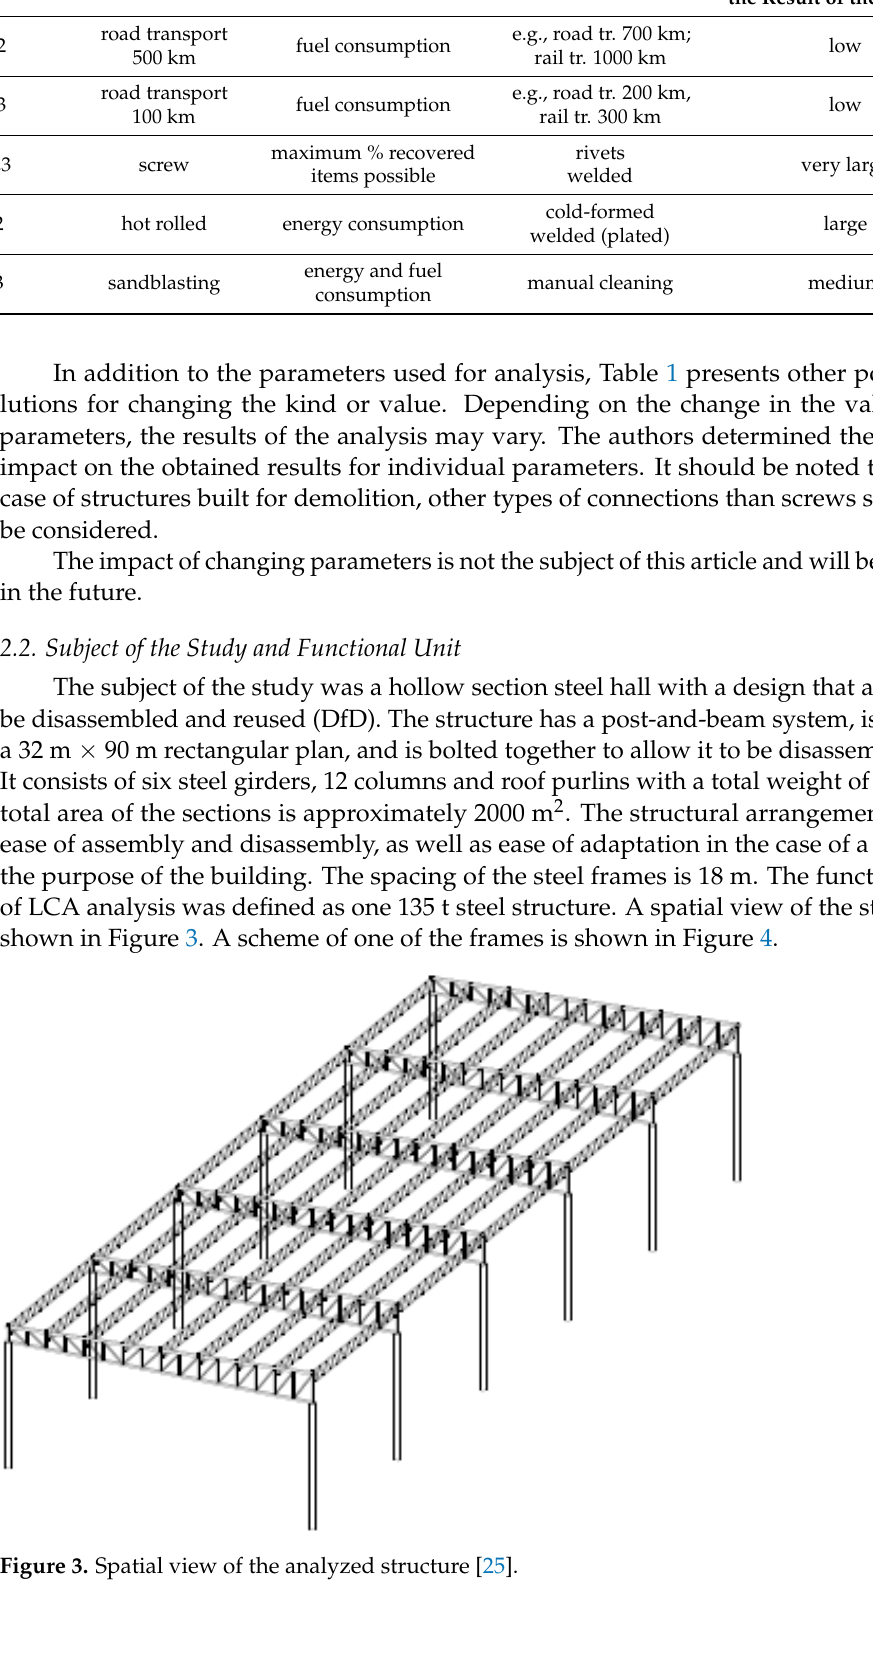
Figure 4. Frame scheme of the structure under consideration [25]. Table 2 summarizes the steel structure data relevant to the analysis.